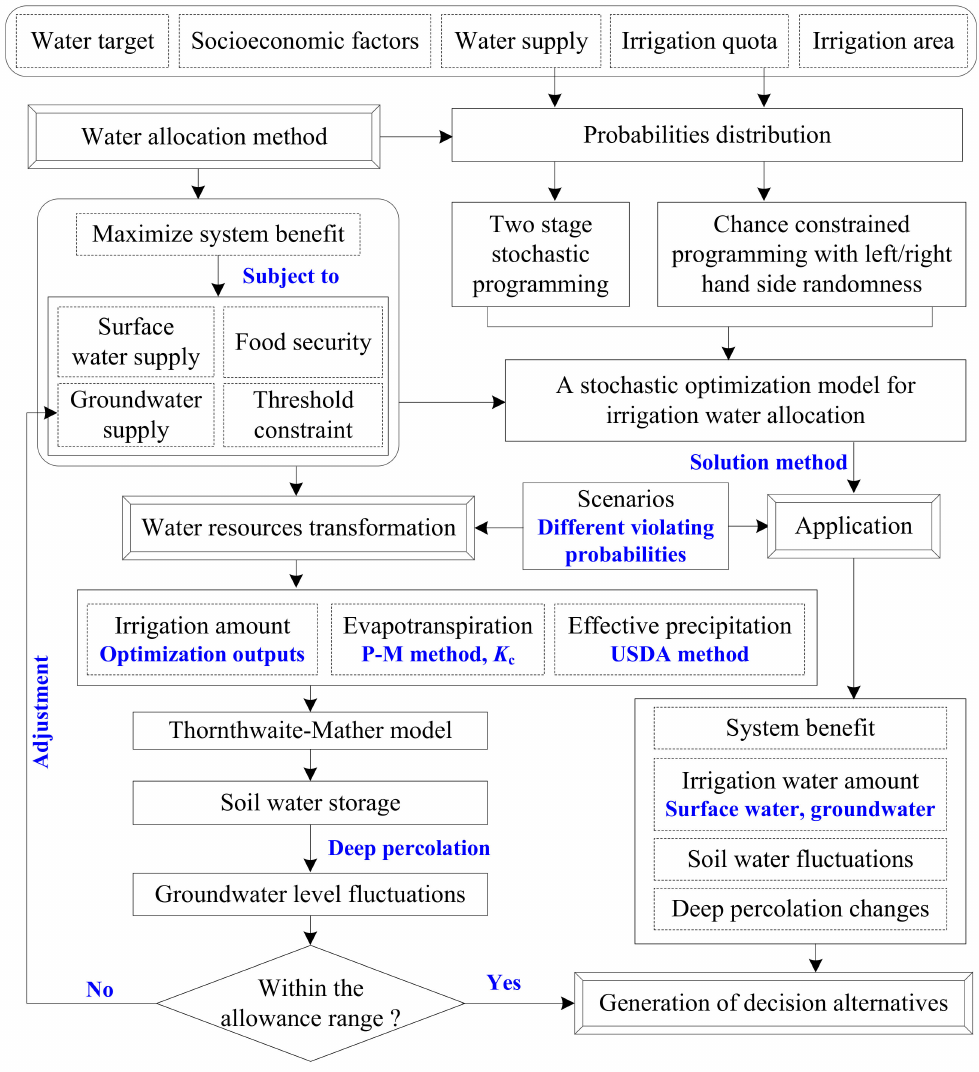
Figure 1. Decision making